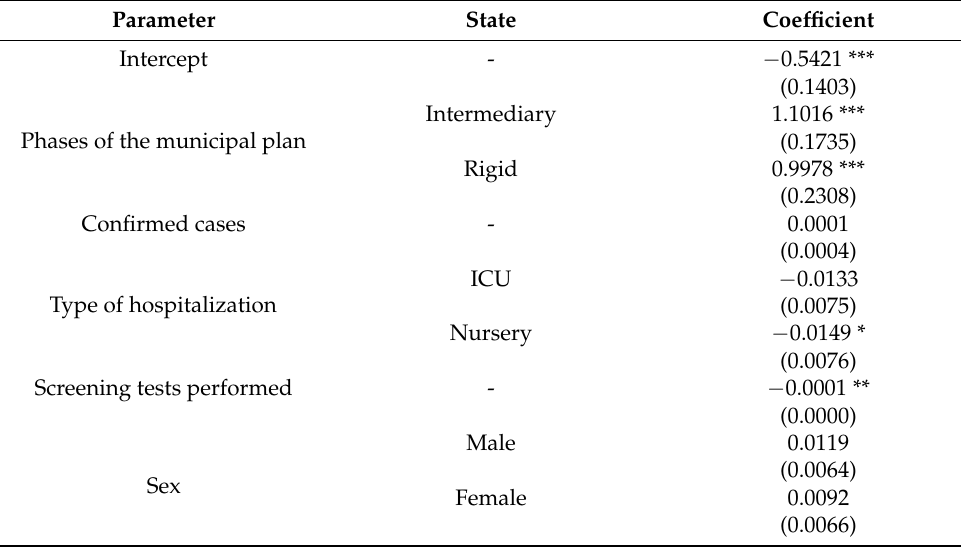
Table 3. Poisson model data referring to COVID-19 notifications to the Municipal Health Department of Uberl â ndia